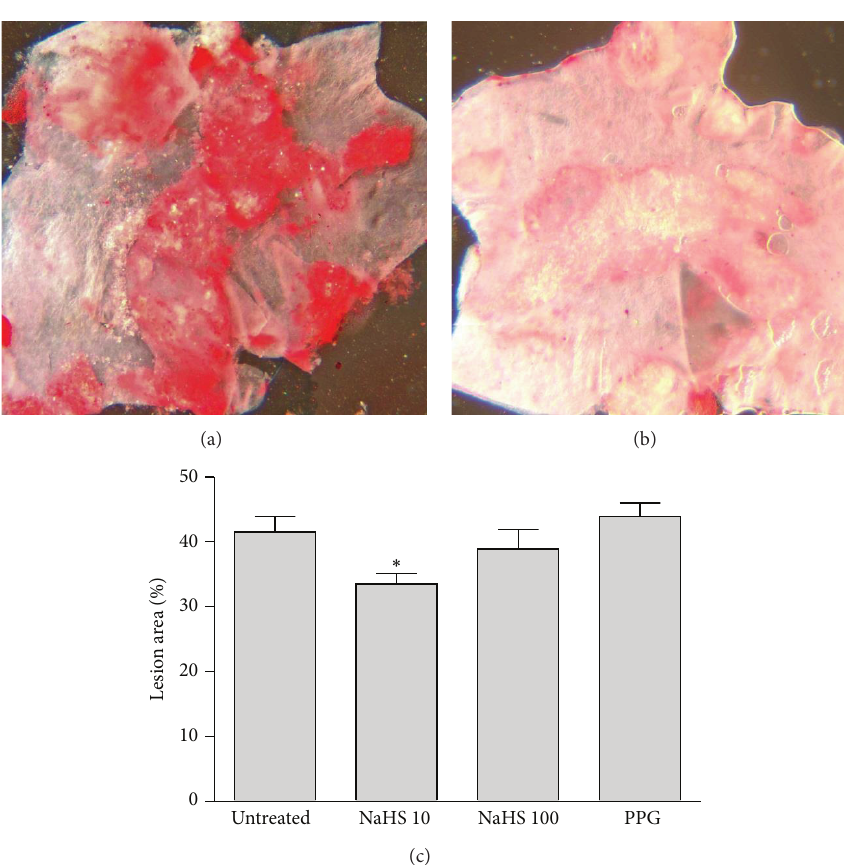
Figure 2: Representative sections of aorta from (a) untreated and (b) NaHS (10 𝜇 mol/kg/day) treated fat-fed ApoE −/− mice. (c) Group data for analysis of total lesion area in fat-fed ApoE −/− mice chronically treated with NaHS 10 or 100 𝜇 mol/kg/day or PPG 30 mg/kg/day. ∗ 𝑃 < 0.05 , ANOVA, untreated versus treated, 𝑛 = 9 – 12